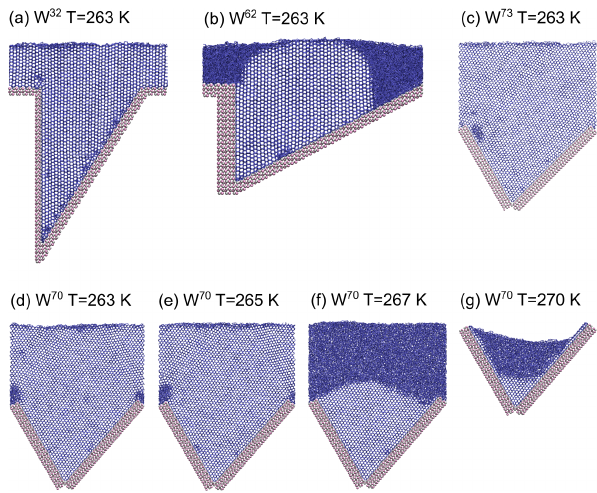
Figure 9. Simulations of ice outgrowing wedge systems at T = 263K and the effect of temperature on the ice growth in the W 70 system using the mW model. (a) W 32 and (b) W 62 at T = 263K, (c) W 73 at T = 263K, (d) W 70 at T = 263K, (e) W 70 at T = 265K, (f) W 70 at T = 267K, and (g) W 70 at T = 270K. Ag and I ions are shown in silver and pink, respectively, and the hydro- gen bond network between mW water molecules is shown by blue